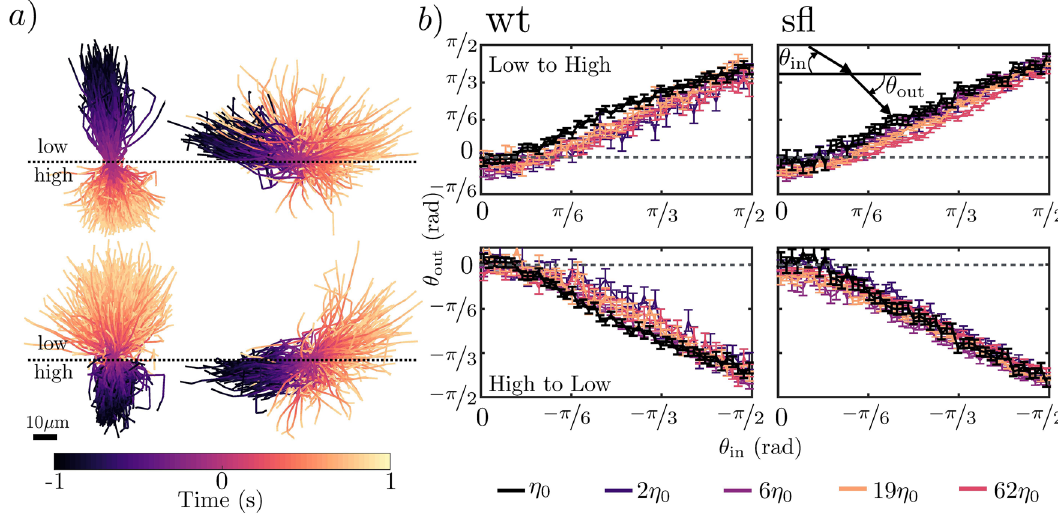
Figure 4. Left: examples of low and high incoming angle trajectories for wt CR trying to cross from low to high (0.30% MC, 6 η 0 ) viscosity region and viceversa; Right: resulting outgoing angle for a given incoming angle when CR try to cross the interface. The black line indicates a control experiment, in which algae are crossing from the 5 low viscosity region to an identical one. For each line, ∼ 10 crossings were recorded and analysed. Figure panels were arranged and labels/legends were added using the proprietary software Affinity Designer 1.8 (https ://affin ity.serif .com/en-gb/desig